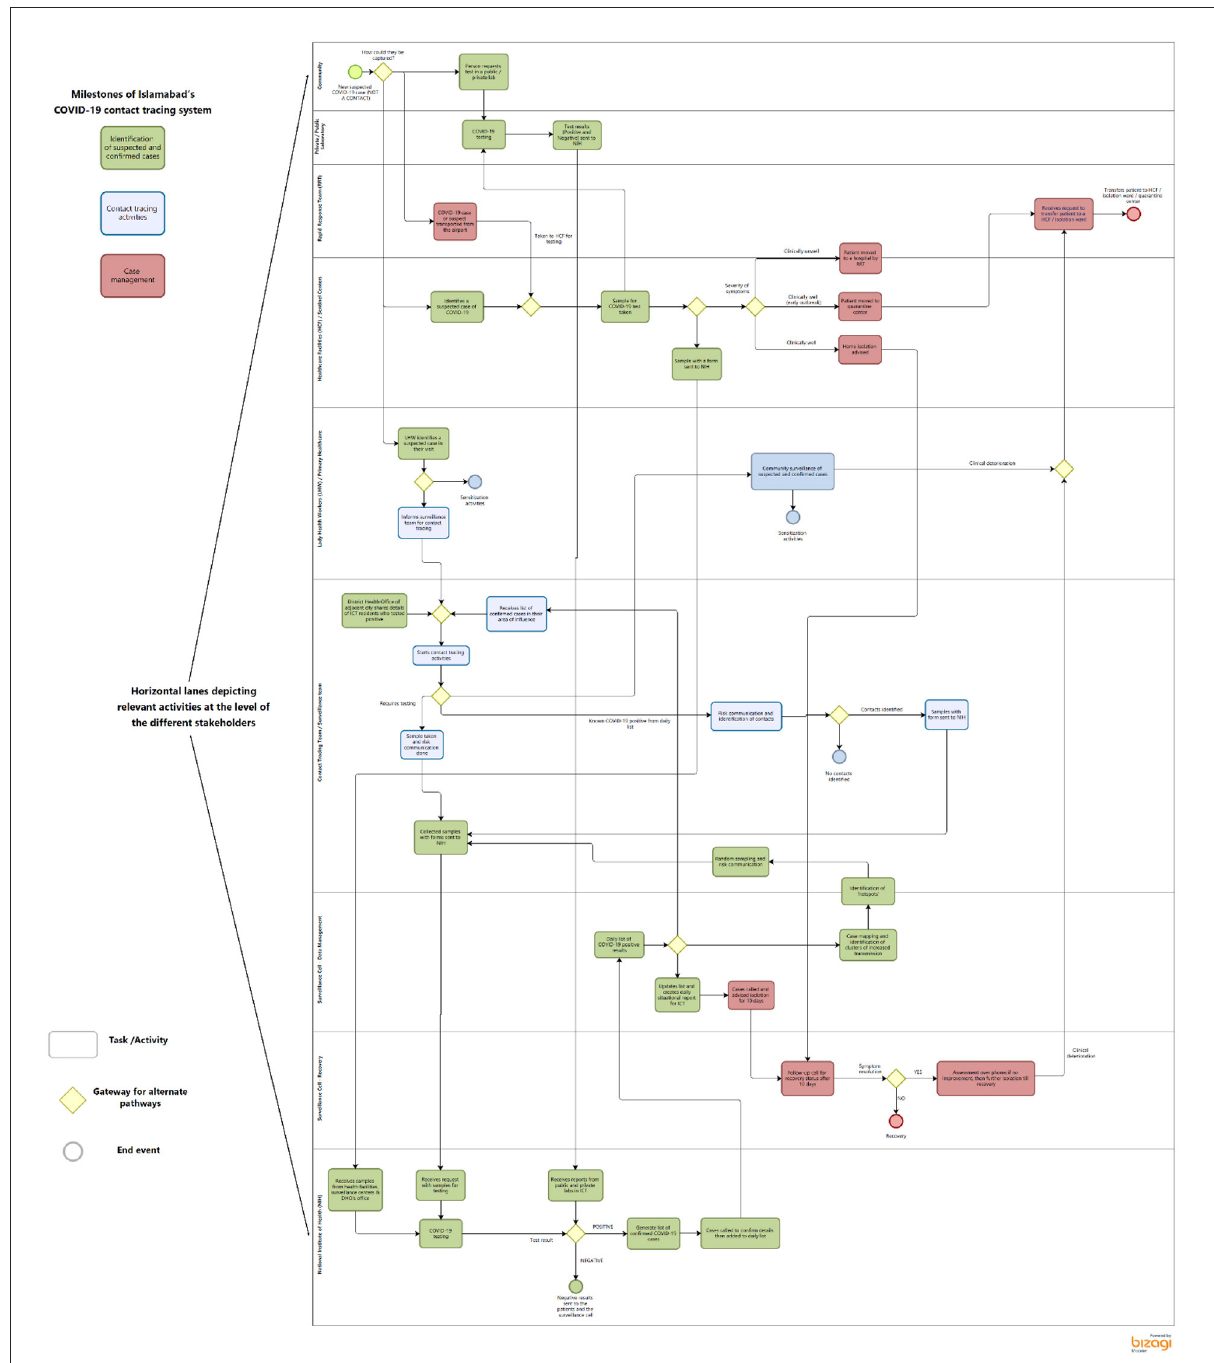
FIGURE2 Process map describing the contact tracing activities in ICT.